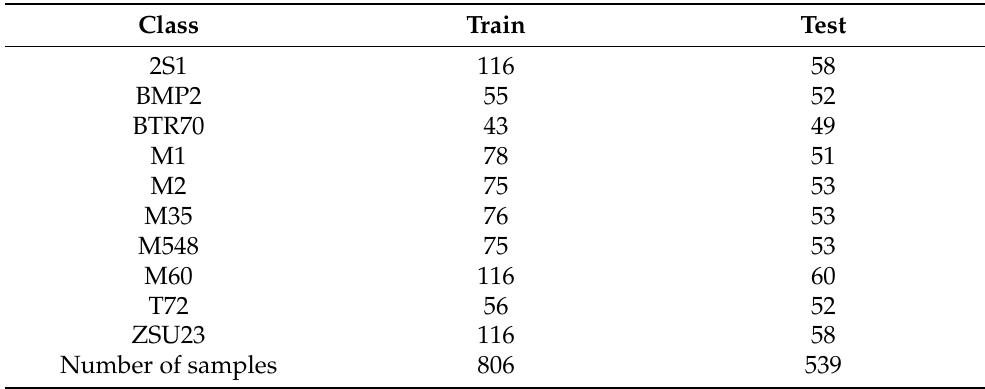
Table 5. Number of samples for each type of target in the SAMPLE